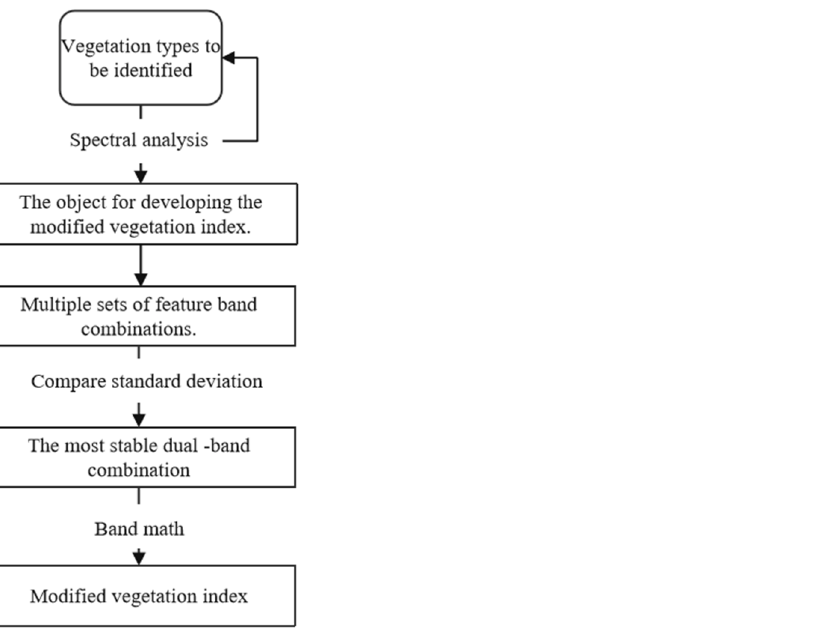
Figure 4. Flow chart for developing the modified vegetation index.